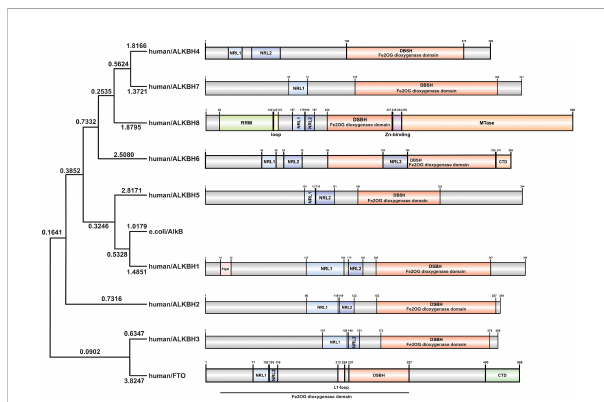
FIGURE 3 The Phylogenetic tree and function domains of human AlkB homologs. The protein sequences of human AlkB homologs and AlkB of E. coli were obtained from the UniProt database (https:// beta.uniprot.org) using the fi rst isoform if there were. MEGA11 (28) was used to conduct the analysis. In detail, the sequences were aligned with the ClustalW option. The phylogenetic tree was computed with “ Construct/Text Maximum Likelihood Tree, ” Bootstrap analysis was performed with 50 replicates. NRL, nucleotide recognition lid; DSBH, double-stranded b -helix domain; RRM, RNA recognition motif; MTase, methyltransferase domain.